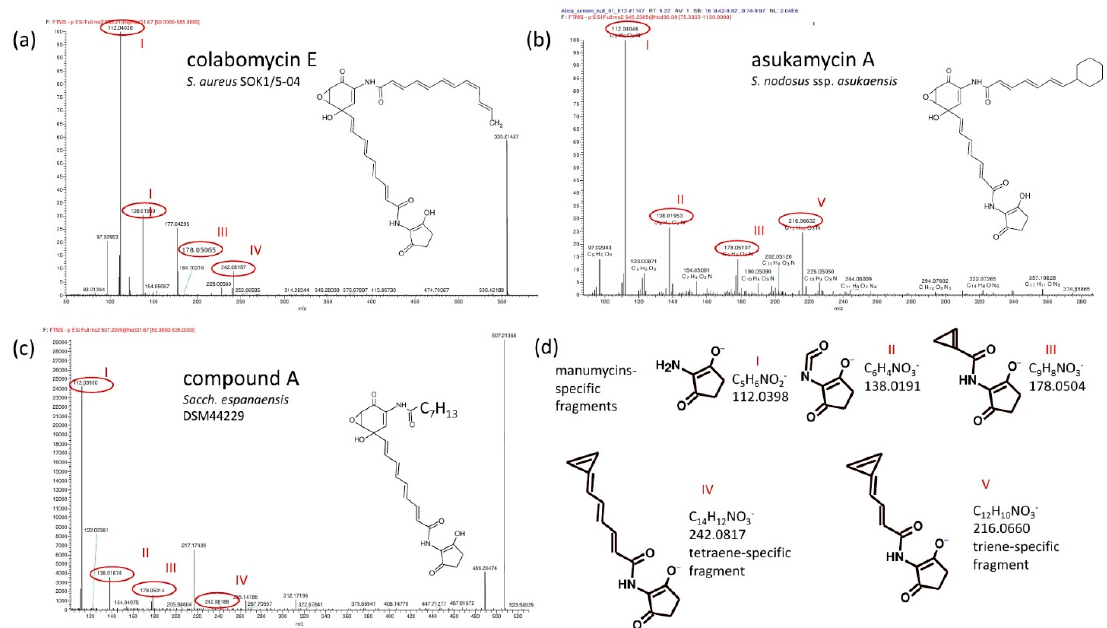
Figure 4. Comparison of ESI − LC-MS/MS spectra of tetraene colabomycin E ( a ), triene asukamycin A ( b ), and compound A ( c ) The corresponding fragment structures ( d ) were predicted by Mass Frontier 7.1 software (Thermo Scientific) based on the exact molecular mass. Typical fragments shared by all manumycins containing the C 5 N unit are shown (I, II, III) together with trienic (V) and tetraenic (IV) lower chain-specific fragments.